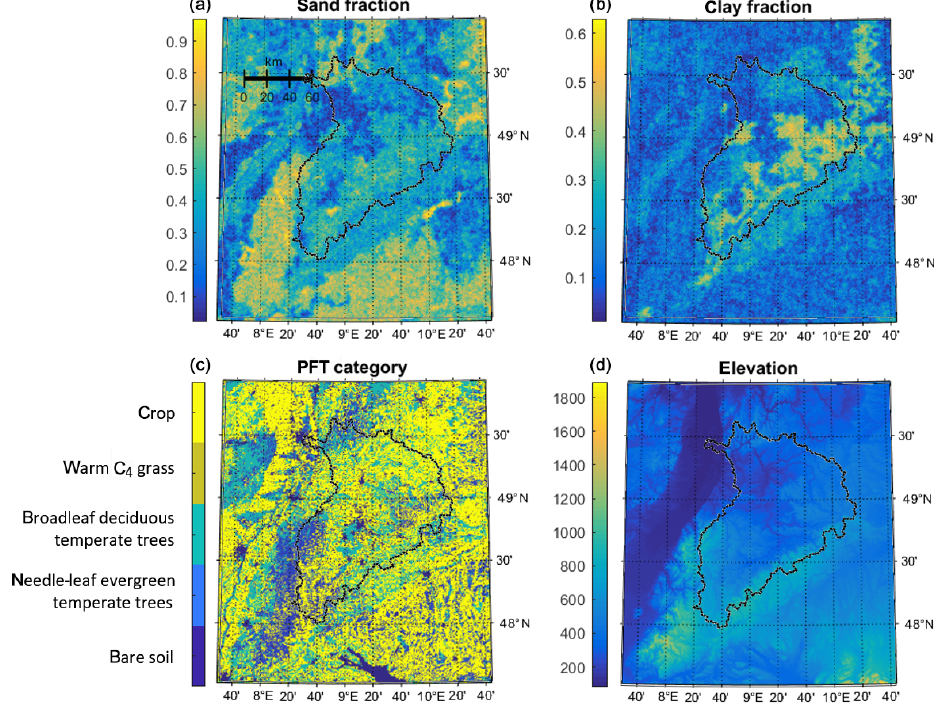
Figure 1. TerrSysMP simulation area at 400m resolution with the Neckar catchment roughly in the center indicated by the black line. Soil sand (a) and clay fractions (b) are displayed in (a, b) , while the plant functional types (PTFs) used by CLM are shown in (c) , and topography (in m) in (d)